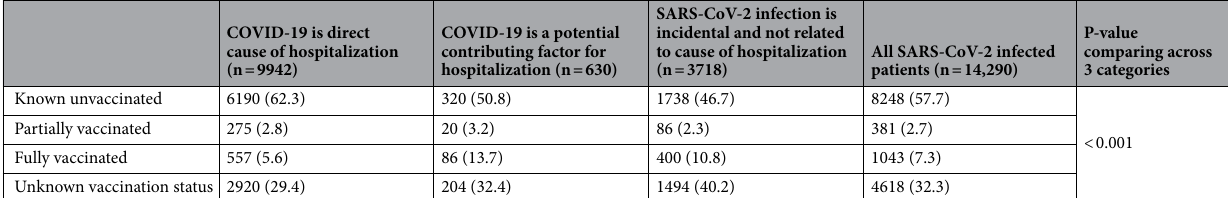
Table 1. Baseline characteristics stratified by type of admission in 14,290 patients with SARS-CoV-2 infection. *Likely an under-count as not collected routinely until Feb,